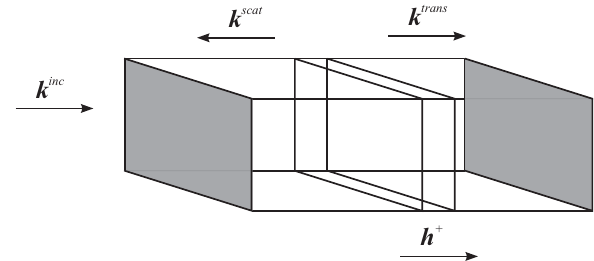
Figure 4: The simulation/measurement configuration. Prop- agation occurs along the positive h -direction, which corre- sponds to x - and y -axis (first and second case, respectively). The central rectangle depicts the metasurface and gray areas the reference planes, at a distance of ± l for the